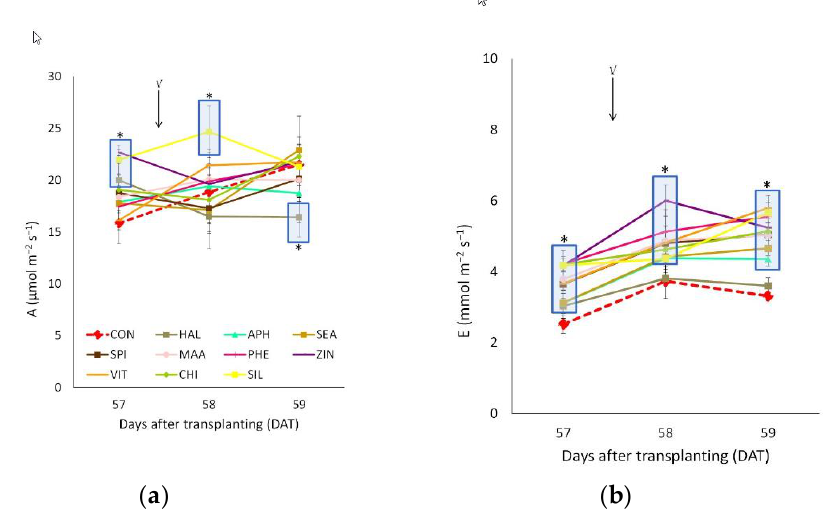
Figure 5. Photosynthetic ( a ) and transpiration ( b ) rates in strawberry leaves treated with different biostimulant products and water (control). 57 DAT: immediately before spray; 58 DAT: 24 h after spray; 59 DAT: 48 h after spray. Arrow indicates the fifth biostimulant application. Vertical bars indicate mean ± SD, n = 4. Asterisk (*), and the blue rectangle in the background indicates the group of treatments that significantly differed from control according to Dunnett’s test ( P < 0.05); no asterisk indicates absence of any significant differences. Table 9. Yield parameters (final yield, number of fruits per plant and mean fruit weight) as affected by biostimulant products.